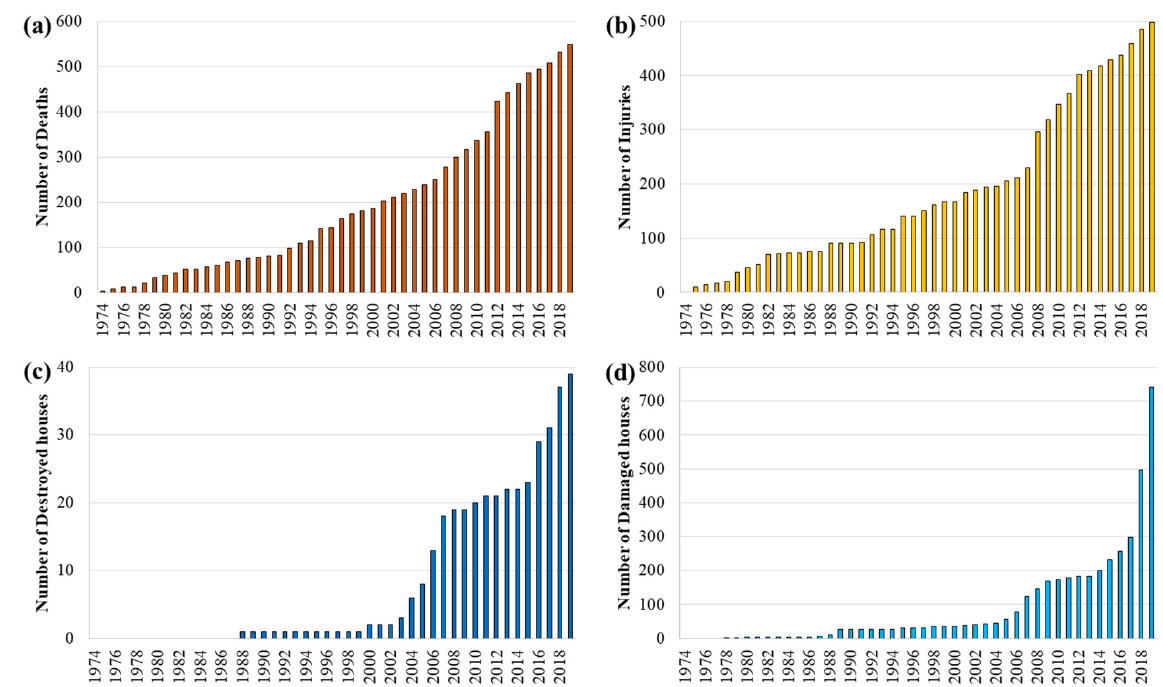
Figure 8. Cumulative lightning accidents in Sri Lanka, from 1974 to 2019: ( a ) number of deaths; ( b ) number of injuries; ( c ) number of destroyed houses; ( d ) number of damaged houses.